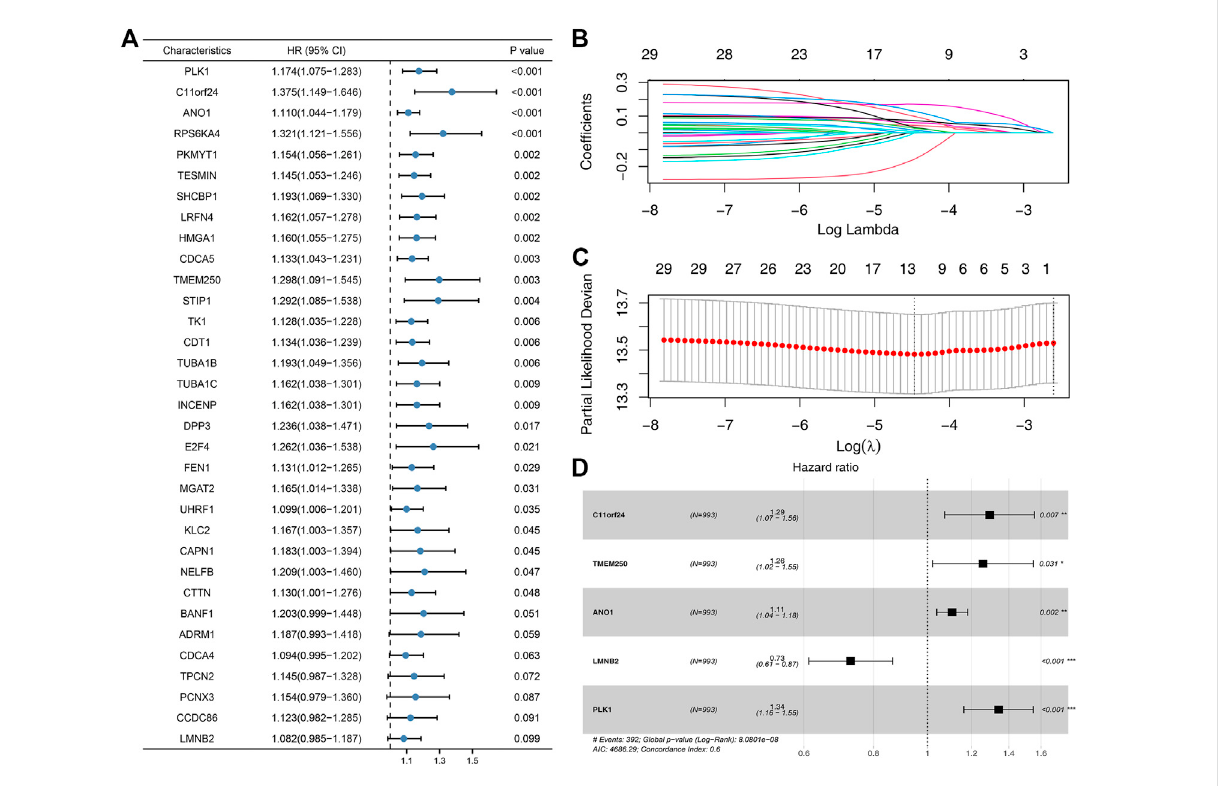
FIGURE 8 Identi fi cation of the prognosis signature based on the FADD-regulated genes. Notes: (A) Univariate Cox regression based on the FADD-regulated genes; ( B-C) : LASSO regression; (D) Multivariate Cox regression based on the genes identi fi ed by LASSO